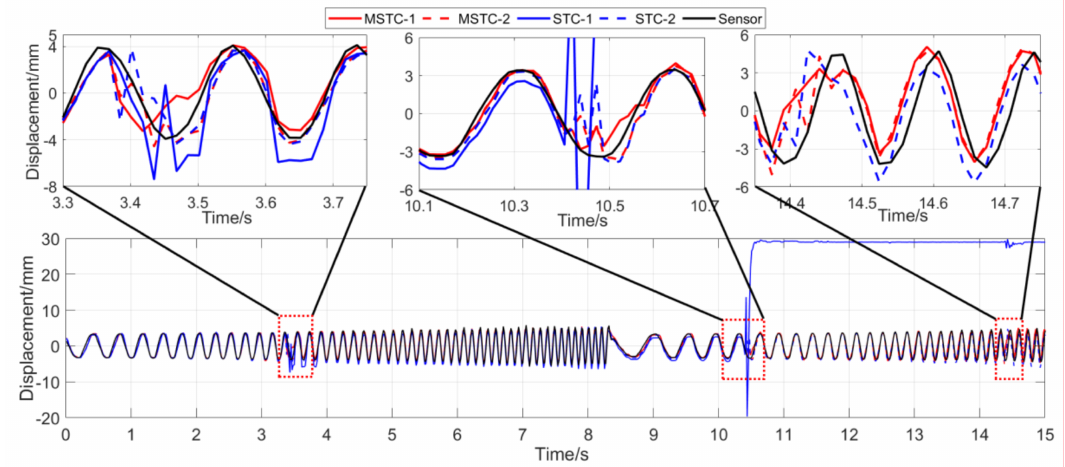
Figure 21. Displacement time history and local amplification in Scenario IV (59.96 FPS).